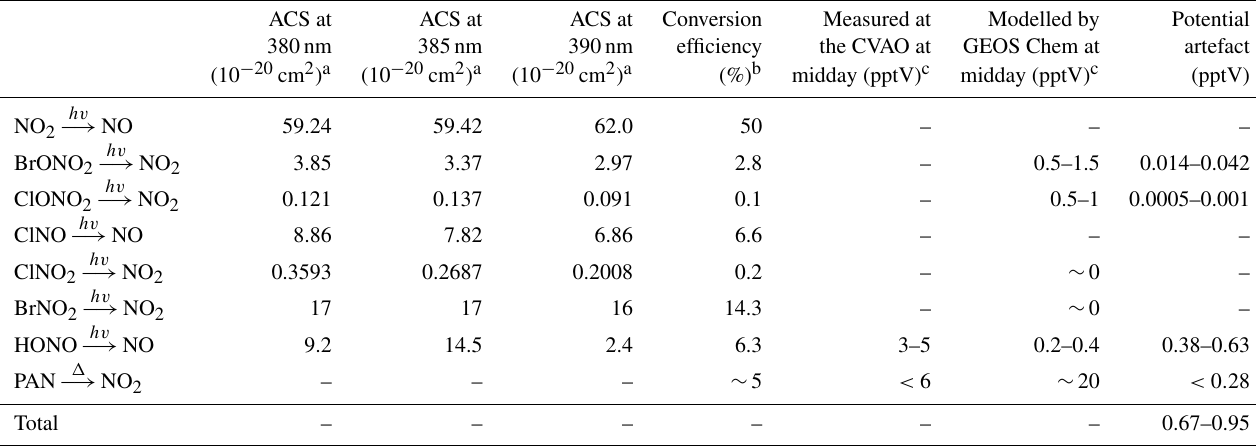
Table 3. Potential sources of NO 2 artefacts at the